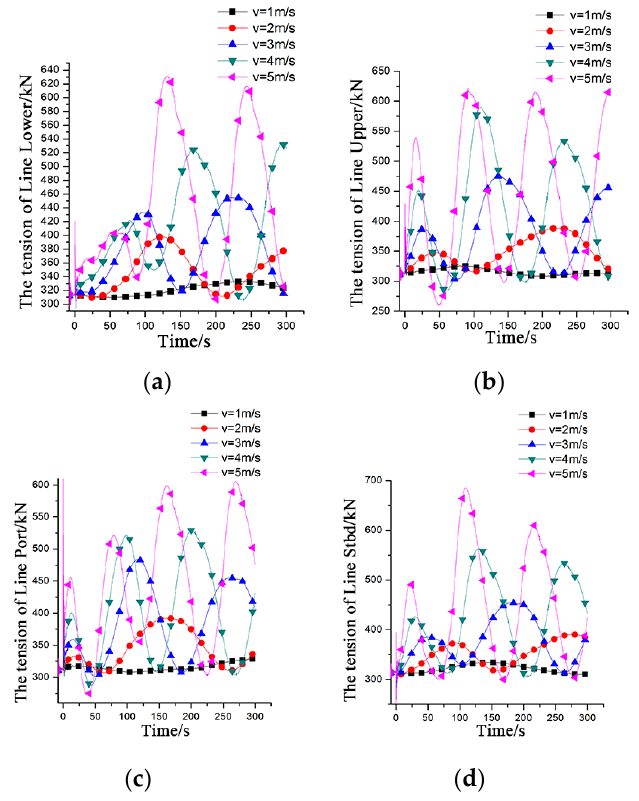
Figure 18. The time domain image of cables tension of the rigid truss trawl system in rotating towing under fixed turning radius: ( a ) Line Lower; ( b ) Line Upper; ( c ) Line Port; ( d ) Line Stbd.